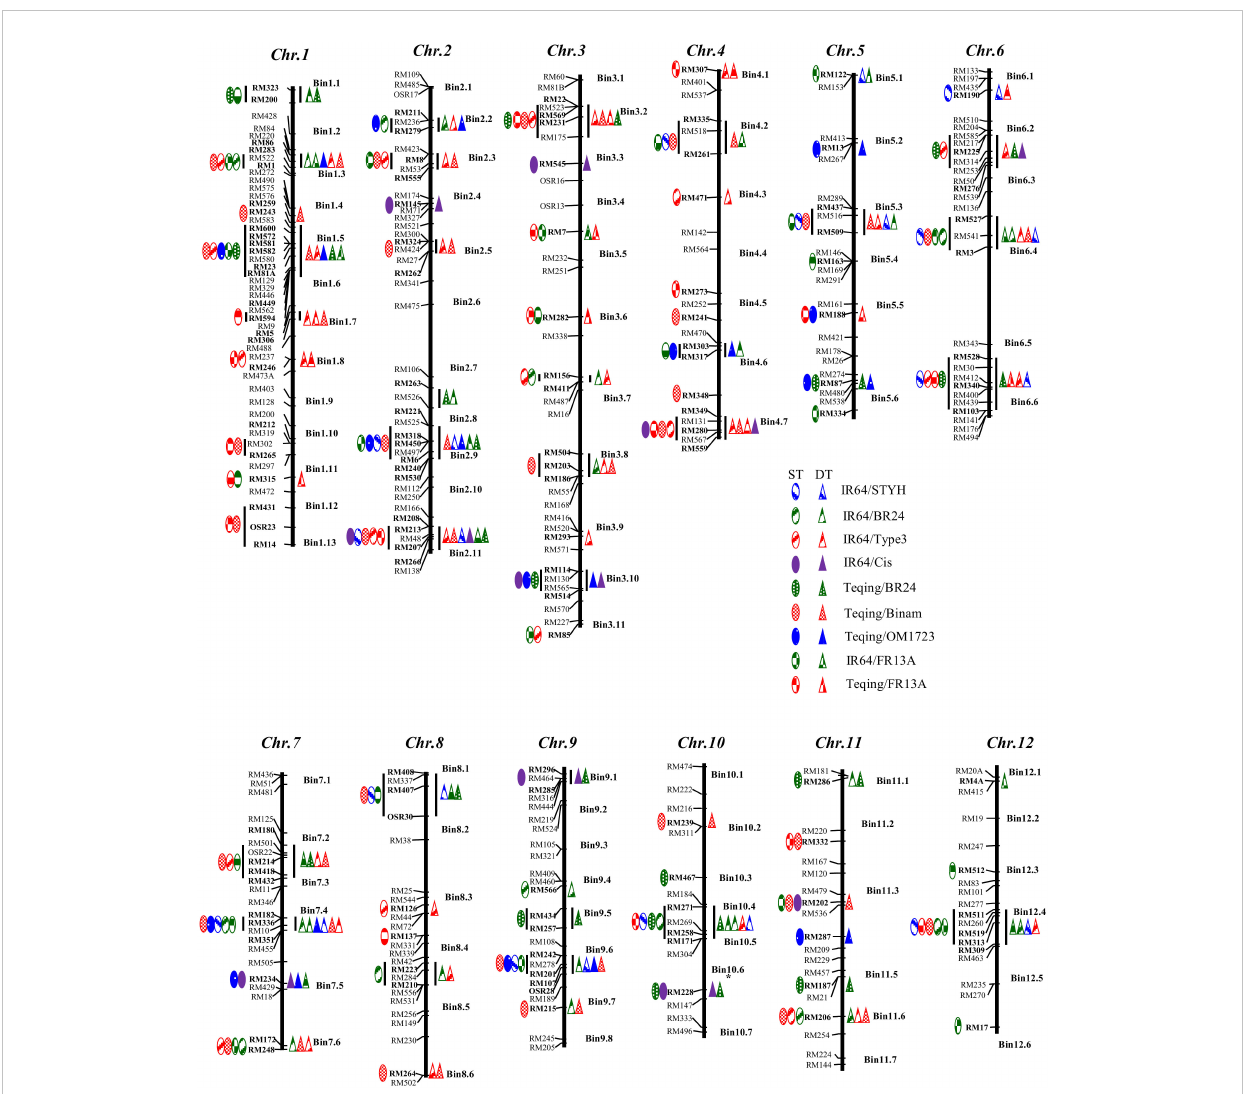
FIGURE 1 Genomic distribution of 127 loci in 59 genomic regions associated with drought and submergence tolerances (DT and ST) identi fi ed in introgression lines selected for DT and ST from nine BC 2 F 2 populations derived from crosses between two recipients (IR64 and Teqing) and 7 donors based on c ² tests of introgression frequencies and linkage disequilibrium analyses (Li et al., 2010; Zhang et al., 2014). Each network contained all DT FGUs (markers and AGs) detected in ILs from a single population/stress case. An AG is de fi ned as a group of unlinked but perfectly and positively associated loci in the ILs from a single population. The hierarchy of each network was determined based on the level of introgression: a single FGU with the highest introgression was put on the top, followed by FGUs with successively decreasing introgression frequencies. The arrowed lines in the networks each has three meanings: (1) the level of introgression of the FGU it pointed; (2) the level of absolute overlap (D ’ = 1.00) between the two FGUs it linked; and (3) the inclusive relationship of the FGUs at the lower and upper levels. The number under each marker represents the bin and the one under an AL indicates the number of loci it